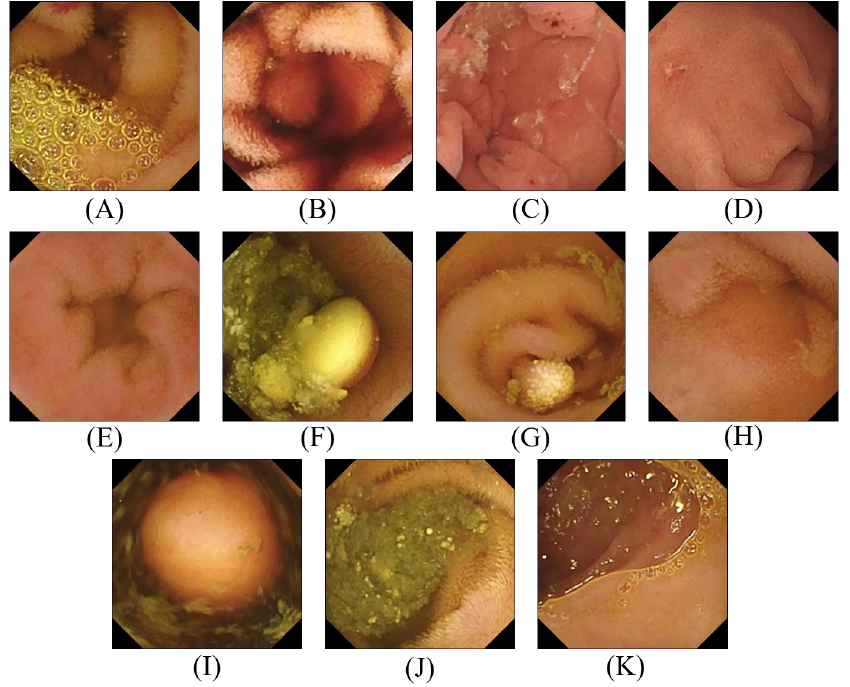
Figure A1. Examples of images in the Kvasir-Capsule dataset [27]. ( A ) Angiectasia; ( B ) Blood-fresh; ( C ) Blood-hematin ( D ) Erosion; ( E ) Erythema; ( F ) Foreign Body; ( G ) Lymphangiectasia; ( H ) Normal Clean Mucosa; ( I ) Pylorus; ( J ) Reduced Mucosal View; ( K )